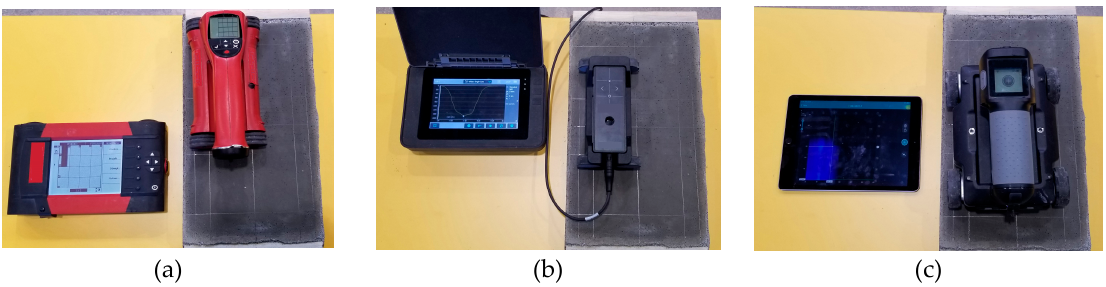
Figure 13. Testing specimens using: ( a ) electromagnetic device (1), ( b ) electromagnetic device (2), and ( c ) radar device (3)